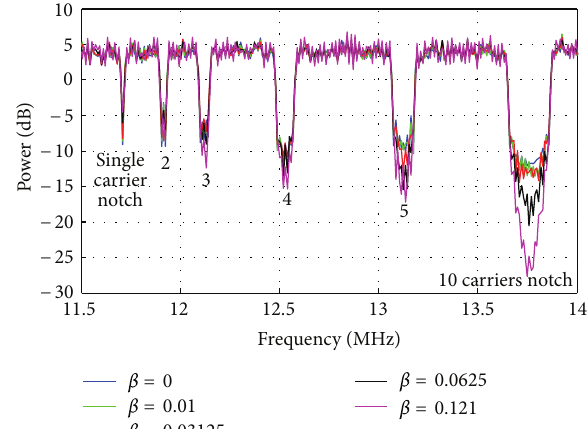
Figure 13: OFDM spectra with different notch widths and depths achieved with different roll-off